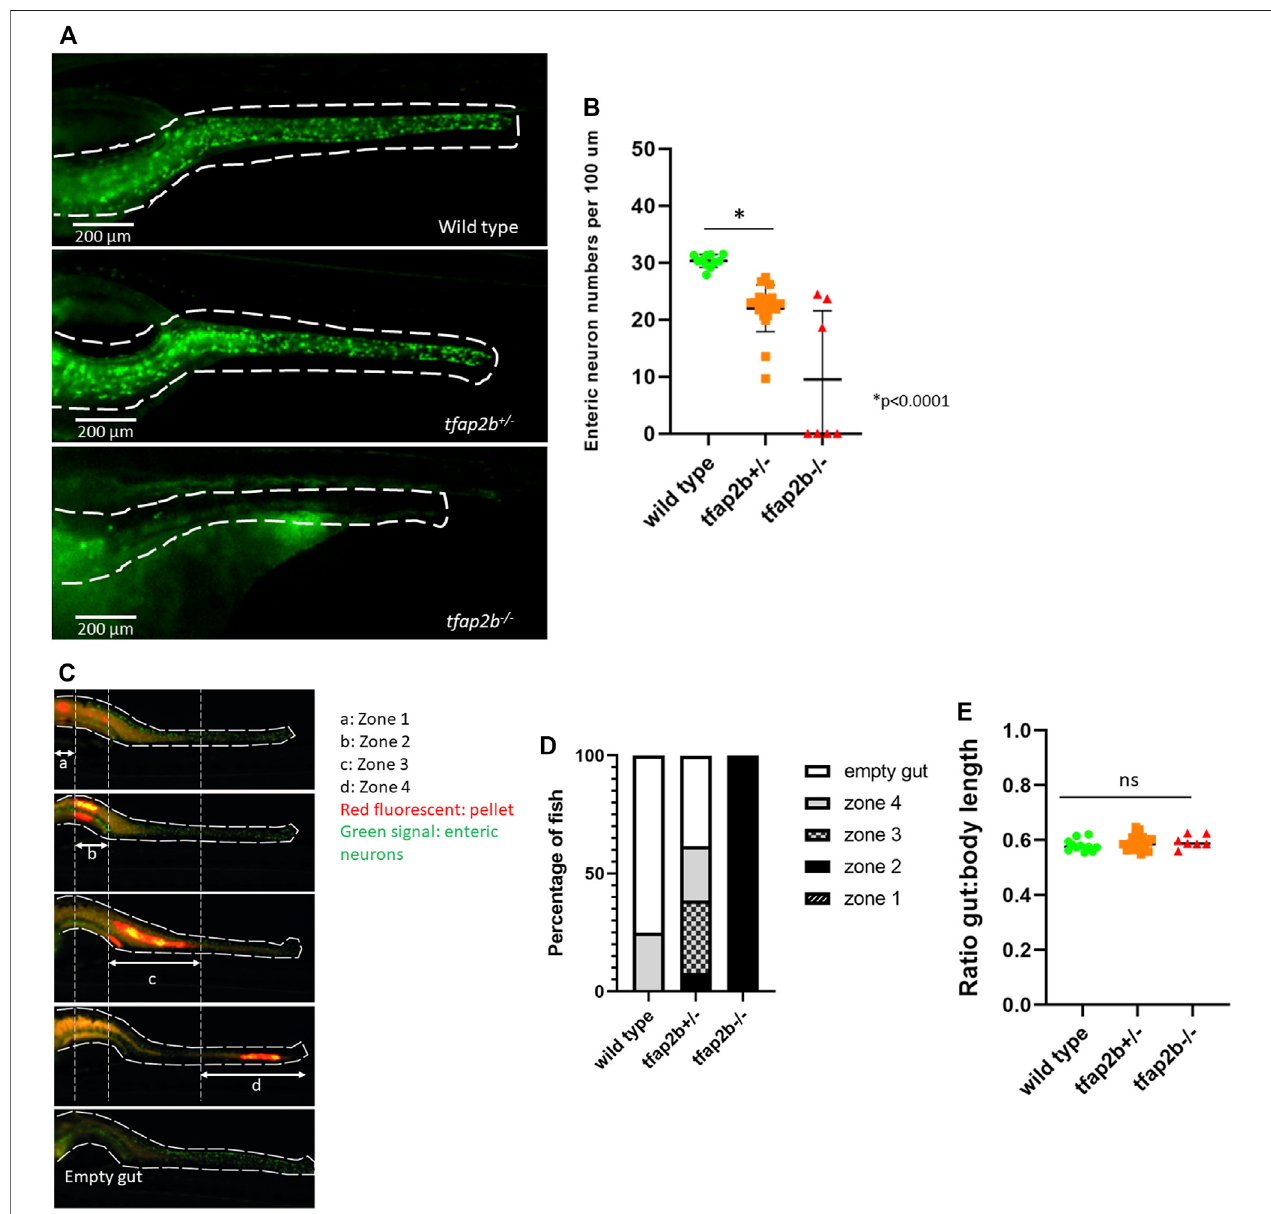
FIGURE 3 | Decreased enteric neuronal numbers and delayed intestinal transit time in tfap2b +/ − zebra fi sh. (A) Image of the zebra fi sh wild type, tfap2b +/ − and tfap2 − / − intestine. Enteric neurons are shown in green and a white dash line delineates the intestine. (B) A signi fi cant reduced number of enteric neurons (* p < 0.0001, unpaired t -test) was found in the tfap2b +/ − fi sh (n = 20) when compared to the wild type fi sh (n = 11). Neurons were counted and presented per 100 µm. Four out of7 tfap2b − / − fi shshowedtotalaganglionosis. (C) Intestinaltransittimewasdeterminedbythepresenceofa fl uorescentpellet(red fl uorescent)intheintestine16 h after food intake ( fi nal measurement). To help evaluation, the zebra fi sh intestine was divided in 4 zones, proximal to distal, and empty. Only fi sh with fl uorescent pellet in zone 1 at time 0 (initial measurement), were selected for this study. (D) A signi fi cant delay in intestinal transit time was observed in tfap2b +/ − fi sh, as 75% of wild type fi sh had an empty intestine16 h after food intake, in comparison with only 38.4% of tfap2b +/ − fi sh ( p < 0.0001, Proportion test). All tfap2b − / − fi sh had pellet retained in zone 2. (E) No difference in the ratio total body length to mouth-distal intestinal length was identi fi ed for wild type, tfap2b+/ − and tfap2b − / − fi sh.